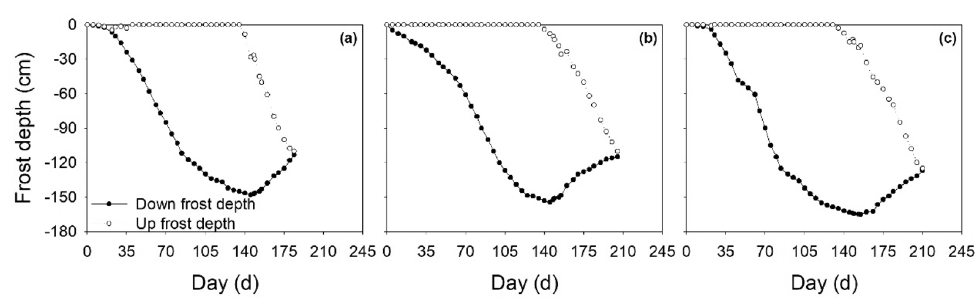
Figure 3. Evolution of soil frost depths in the farmland ( a ), LT grassland ( b ) and AS land ( c ) from 24 October, 2015 to 25 June,